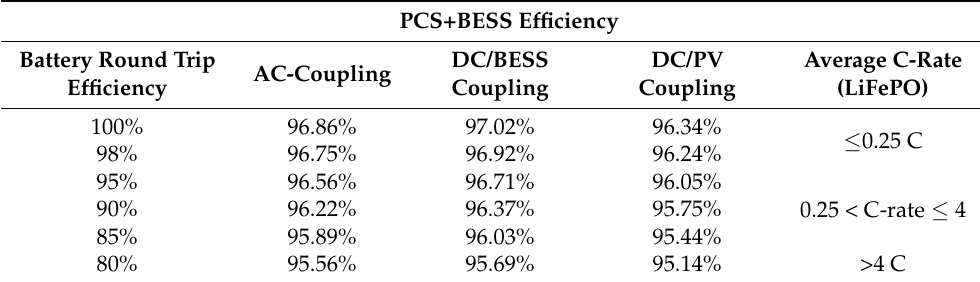
Table A1. PCS+BESS efficiency as a function of the round trip battery efficiency.